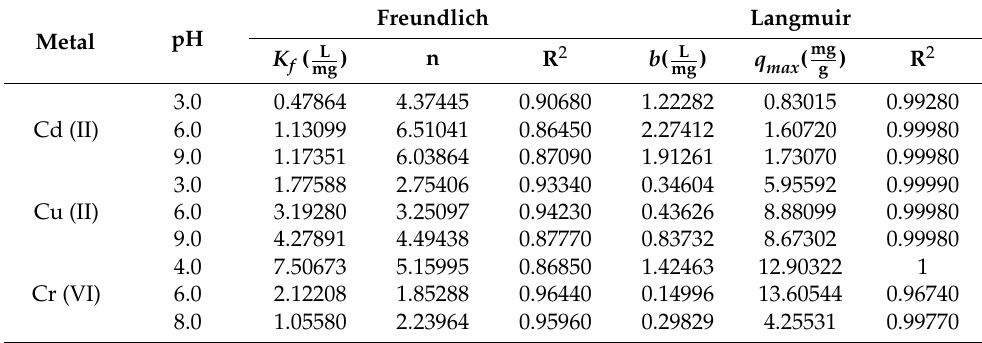
Table 5. Langmuir and Freundlich parameters for the isotherms varying the pH.